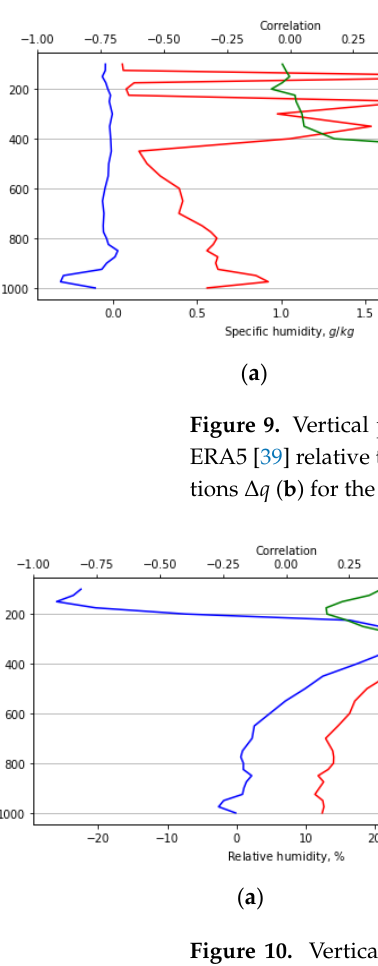
( b ) Figure 11. Vertical profiles of RMSE, Bias, and Corr for the values of temperature based on ERA5 [39] relative to the RAOB [25] data for 2016–2020 ( a ) and the corresponding distribution of devia- tions Δ t ( b ) for the coordinates of the specified aerological stations.